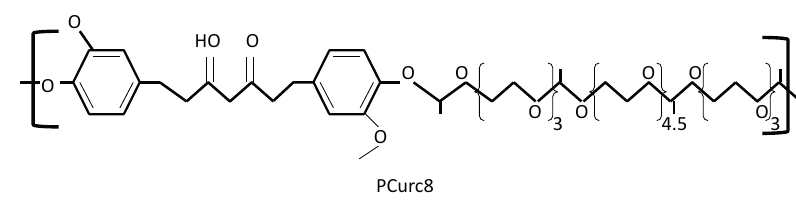
Figure 4. Structure of a polycurcumin PCurc8